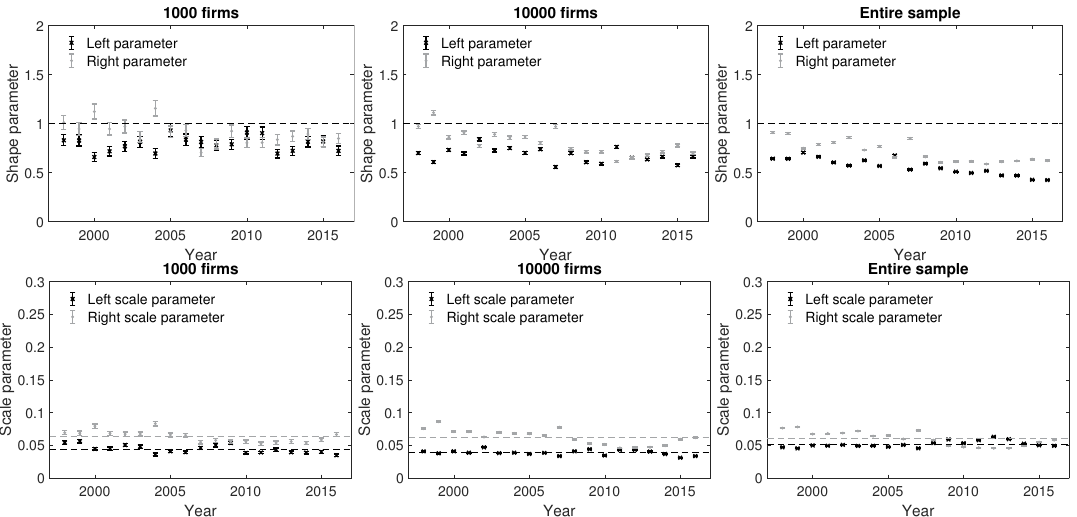
Figure 9. Estimates of the two shape parameters ( α l and α r ) and two scale parameters ( σ l and σ r ) of the AEP distribution for profit rates conditional on size. Error bars show two standard errors. Gray and black dashed lines refer to the median of the estimates of σ l and σ r ,